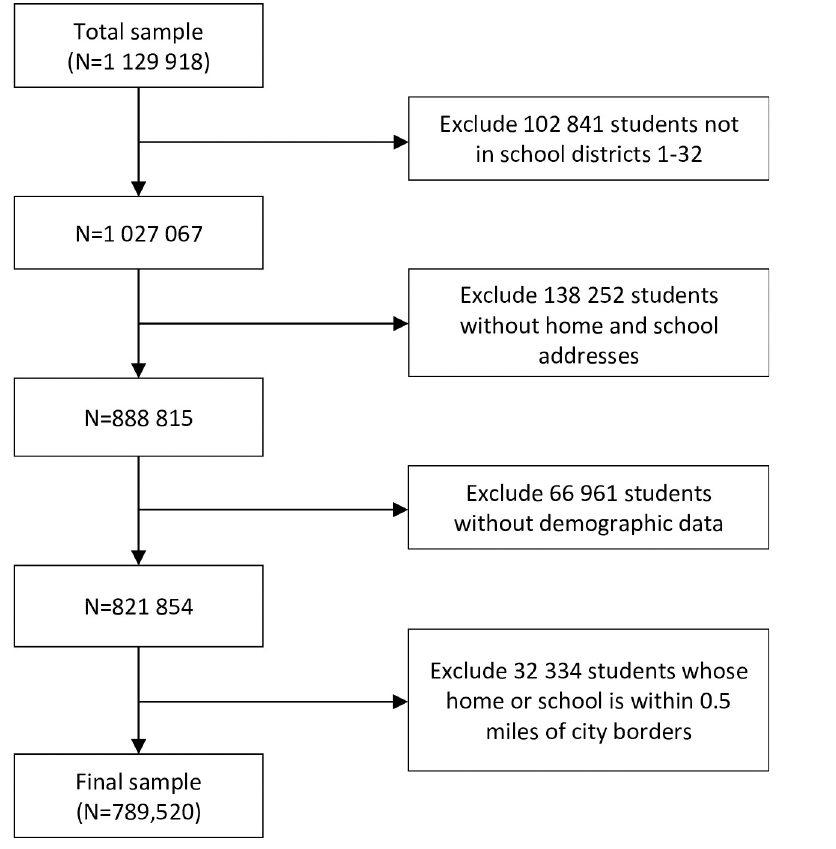
Fig 1. Flow diagram for sample